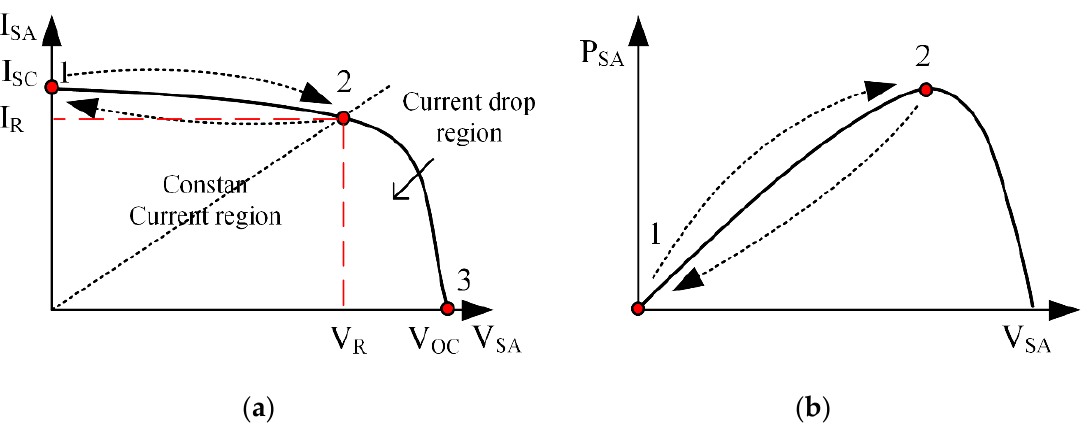
Figure 12. Shunt switch working points. ( a ) U ‐ I characteristic; ( b ) U ‐ P characteristic.